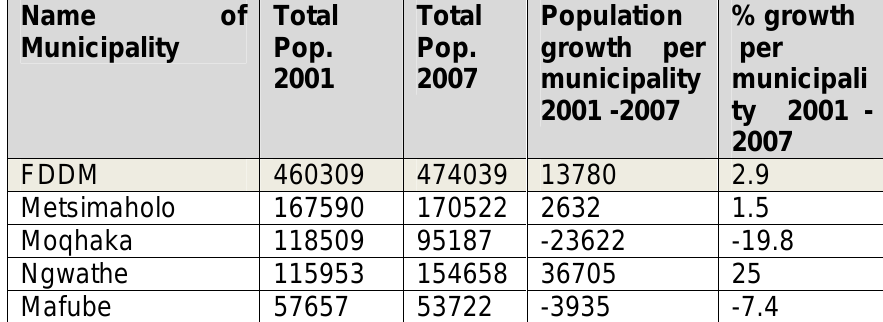
TABLE 1: Population trends in FDDM from 2001 to 2007